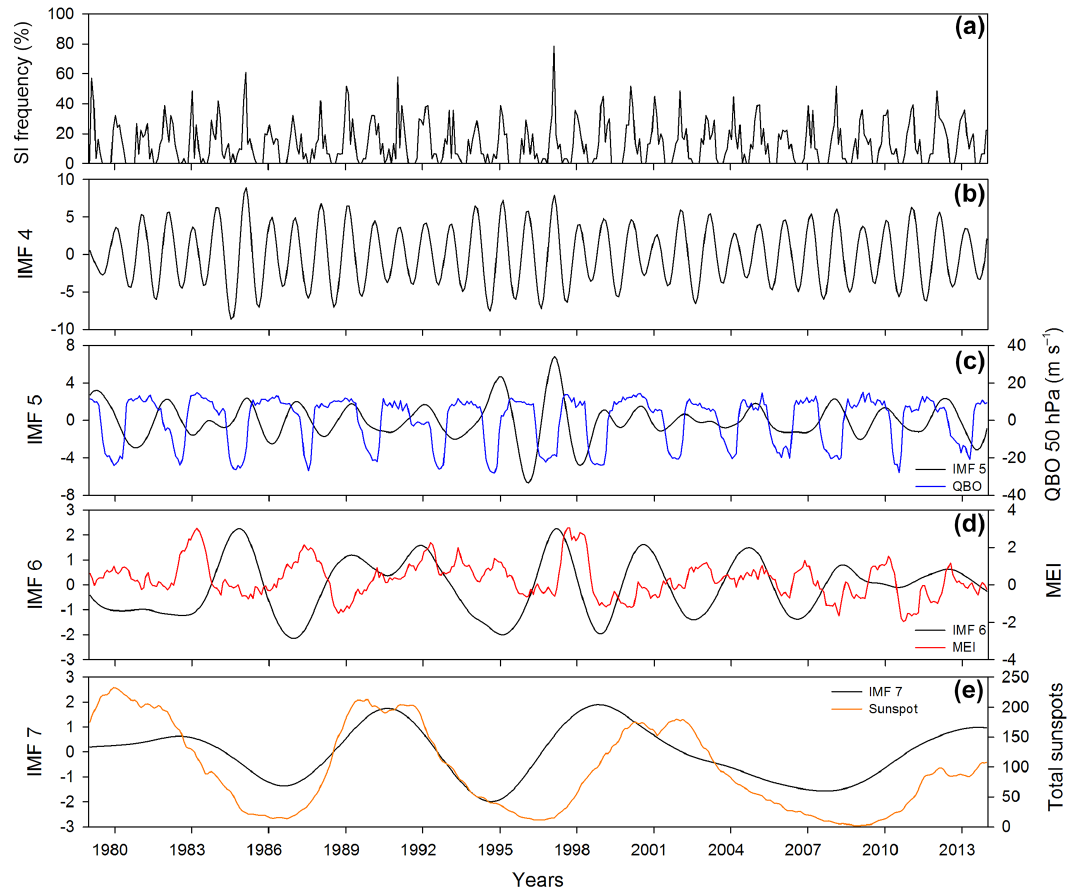
Figure 5. Time series of monthly averaged SI frequency, as retrieved by STEFLUX, at NCO-P (a) , and some of its IMFs (i.e., IMF 4–7, b–e , respectively) resulting from the application of the CEEMDAN analysis. The blue line in (c) represents the equatorial zonal wind at 50hPa, used as a measure of the QBO signal, the red line in (d) depicts the multivariate ENSO index (MEI), and the orange line in (e) indicates the 13-month smoothed monthly total sunspot